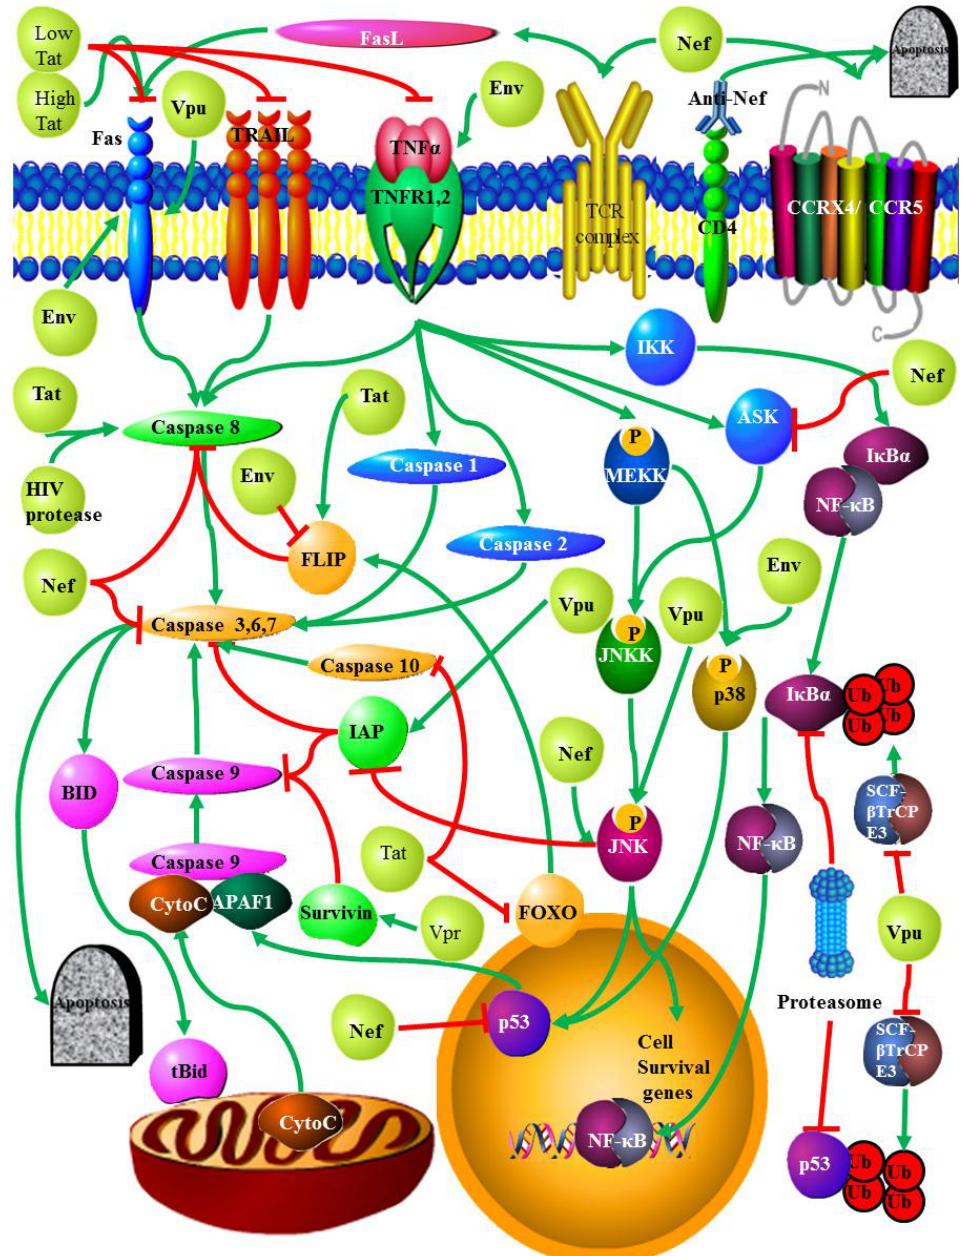
Figure 2. The influence of HIV proteins on the extrinsic apoptotic pathways: HIV proteins influence the expression of death receptors Fas or Tumor necrosis factor (TNF)–related apoptosis-inducing ligand (TRAIL)-R1/R1 (DR4/DR5). Up-regulation of these induces receptor—mediated cell death. HIV proteins also act on caspases, the p53 pathway and influence ubiquitin associated protein